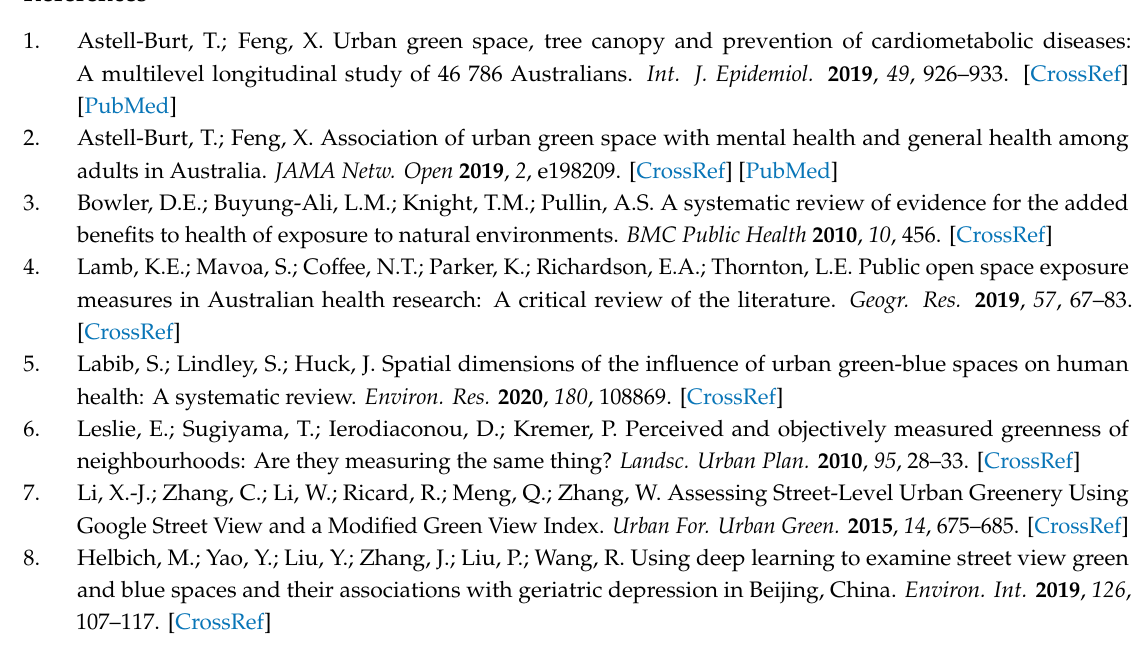
Table S1: Percentage distributions by Age and Sex in the survey compared to Liverpool LGA, Table S2: Comparing early responders with late responders, Table S3: Correlations (Kendall’s Tau) between di ff erent objective greenspace metrics, Table S4: Logistic Regression